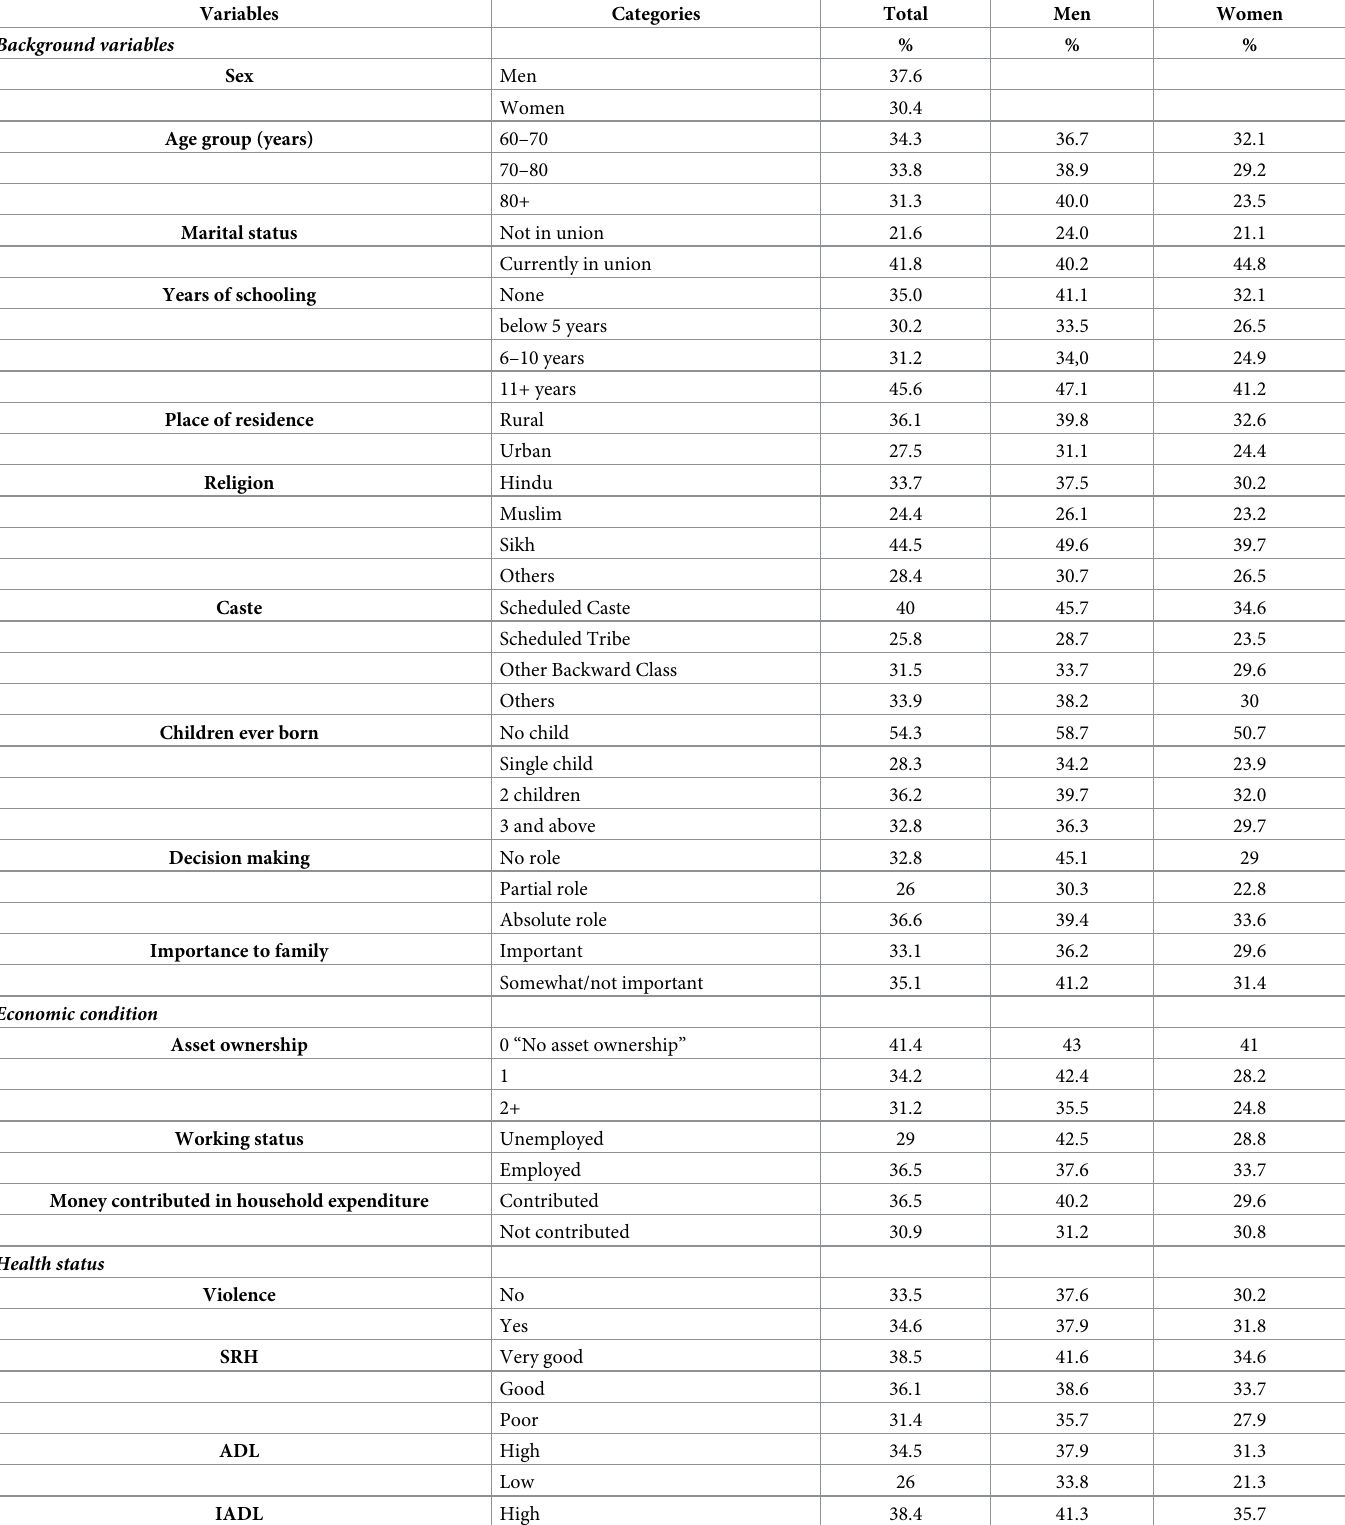
Table 2. Bivariate association between older adults preference over living in private by different background factors in India (N = 9540).